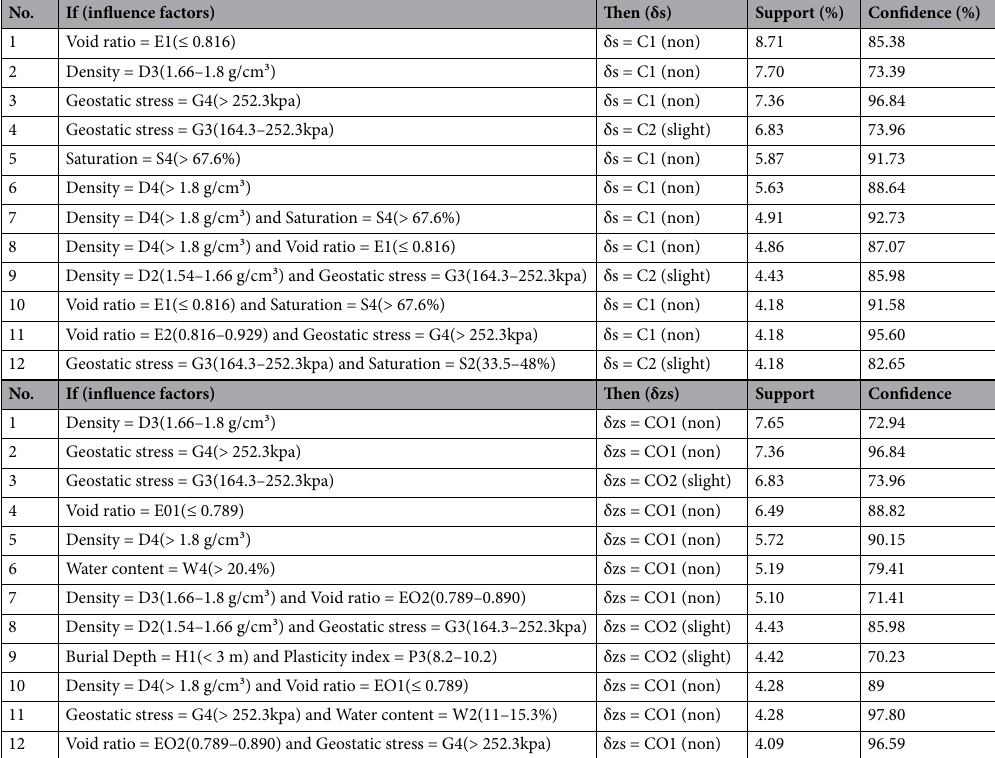
Table 3. Association rules between influence factors and collapsibility (high Support with relatively high